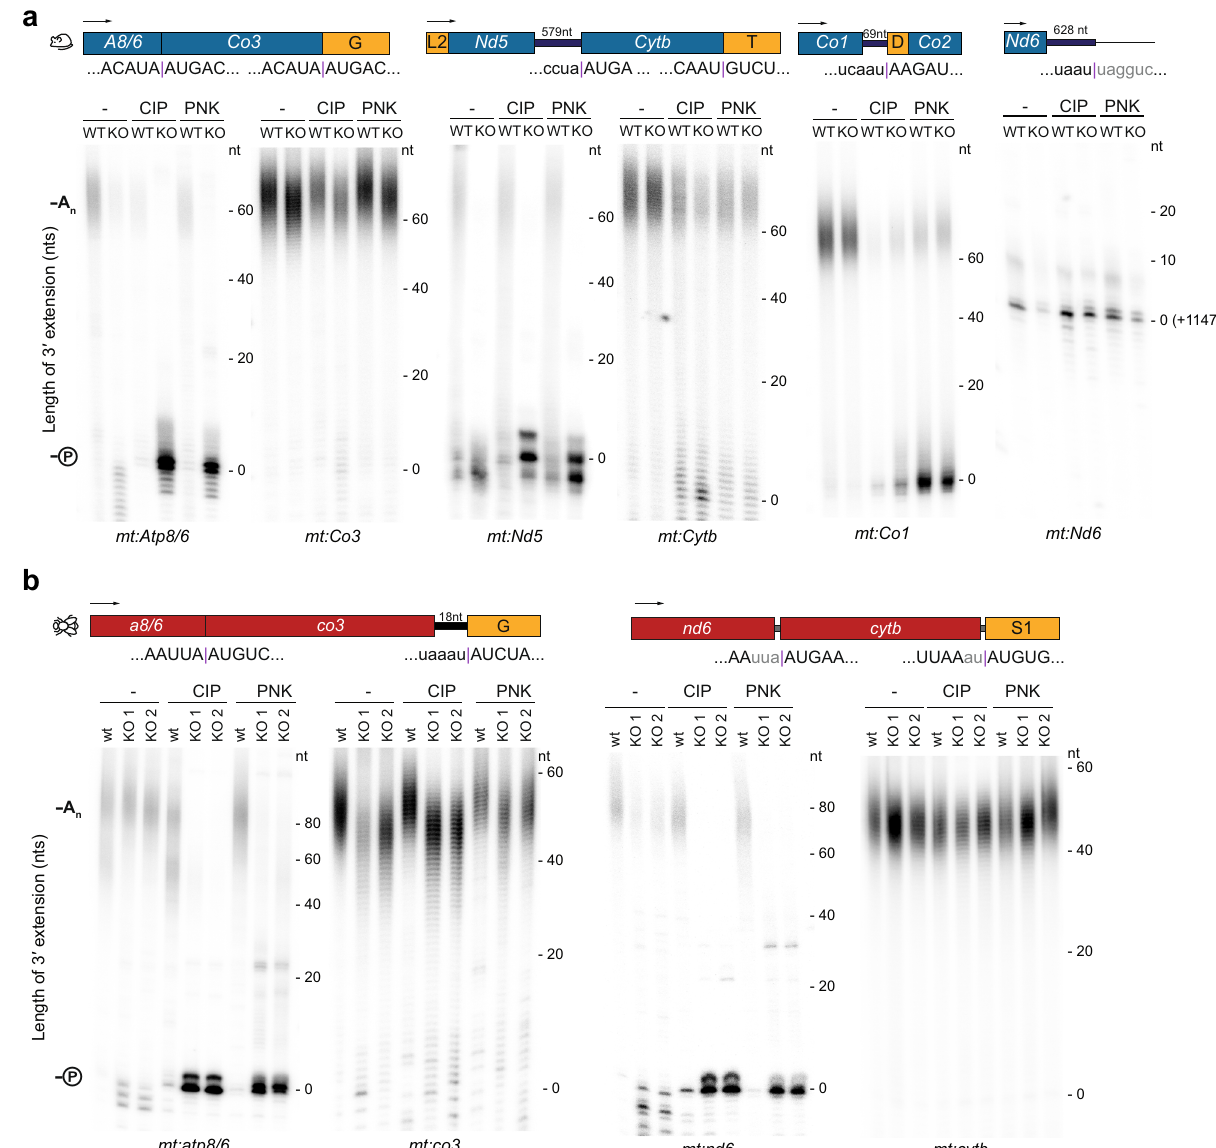
Fig.3|Non-canonicalprocessingofmitochondrialgenejunctionsresultsinthe formation of 3 ′ phosphates that are hydrolysed by DmANGEL or MmANGEL2. a Mitochondrial polyadenylation tail (MPAT) length assay in MmAngel2 KO mouse heart samples, performed with or without CIP or PNK pre-treatment, as indicated. b Mitochondrialpolyadenylationtail(MPAT)lengthassayin DmAngel KO fl ysamples, performed with or without CIP or PNK pre-treatment, as indicated. CIP calf intestinal phosphatase, hydrolyses phosphomonoester bonds. PNK T4